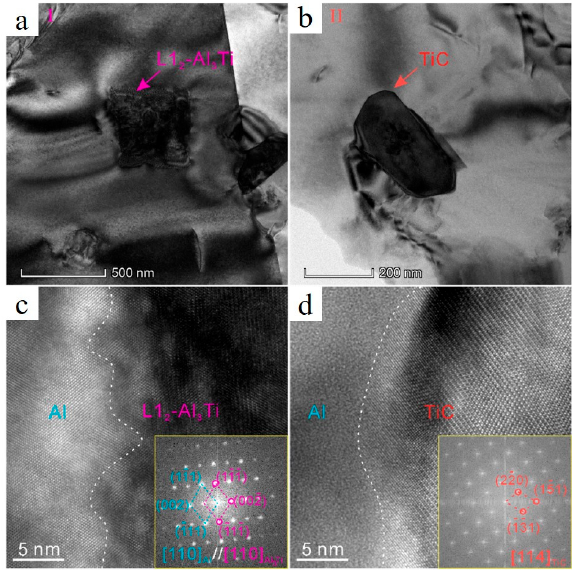
Figure 13. TEM images of L1 2 -Al 3 Ti ( a ) and TiC particles ( b ), HRTEM image and respective FFT pattern of α -Al/L1 2 -Al 3 Ti interface ( c ) and α -Al/TiC interface ( d ) (reproduced with permission from [92]).